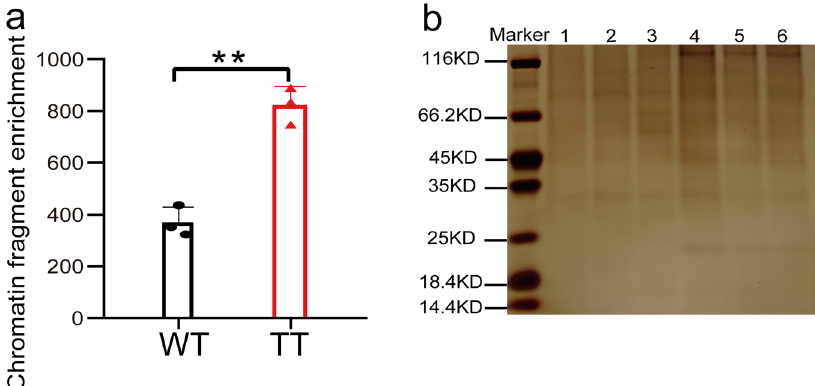
Fig. 6 Analysis of the captured proteins and the relative enrichment of DNA using R-ChIP. a Relative enrichment analysis by R-ChIP from wild-type or transiently transformed plants. WT: wild-type plants; TT: transiently transformed plants.The relative enrichment was calculated as 2 − ( Δ CT1 − Δ CT2) . Δ CT 1: The Ct of the studied (isolated) DNA subtracted from the Ct of the internal control DNA in the products of R-ChIP. Δ CT 2: The Ct of DNA of studied (isolated) subtracted from the Ct of the internal control DNA in the input sample. The promoter region of AtCAT3 used for the qPCR evaluation was site 1 and is shown in in Fig. 7l and Supplementary Data 4. The promoter of AtActin3 (which is far away from the promoter of AtCAT3 ) was used as the internal control. Three replicates (sample size of 500 seedlings) were performed ( n = 3 experiments). Error bar indicates standard deviations of the mean measurements. Asterisks indicate highly signi fi cant difference between two samples (** P < 0.01, t -test). b SDS-PAGE analysis of the proteins captured using R-ChIP. Lanes 1 – 3: the proteins isolated from wild-type plants from three biological replicates, respectively. Lanes 4 – 6: the proteins isolated from transient transformed plants from three biological replicates, respectively. The proteins were stained with silver